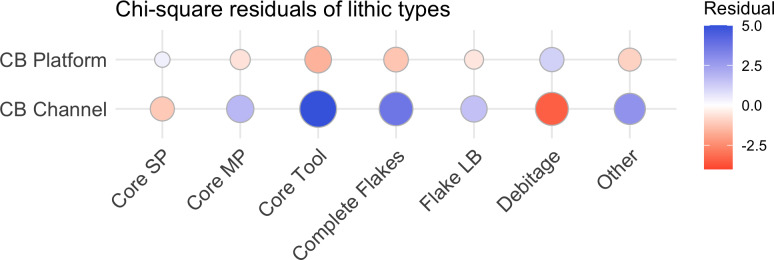
Residual plot for the chi-squared test of artefact types for the Cape Bruguieres artefacts, using the ggcorrplot package [64] in R.Blue circles indicate an over-representation, and red circles indicate an under-representation.